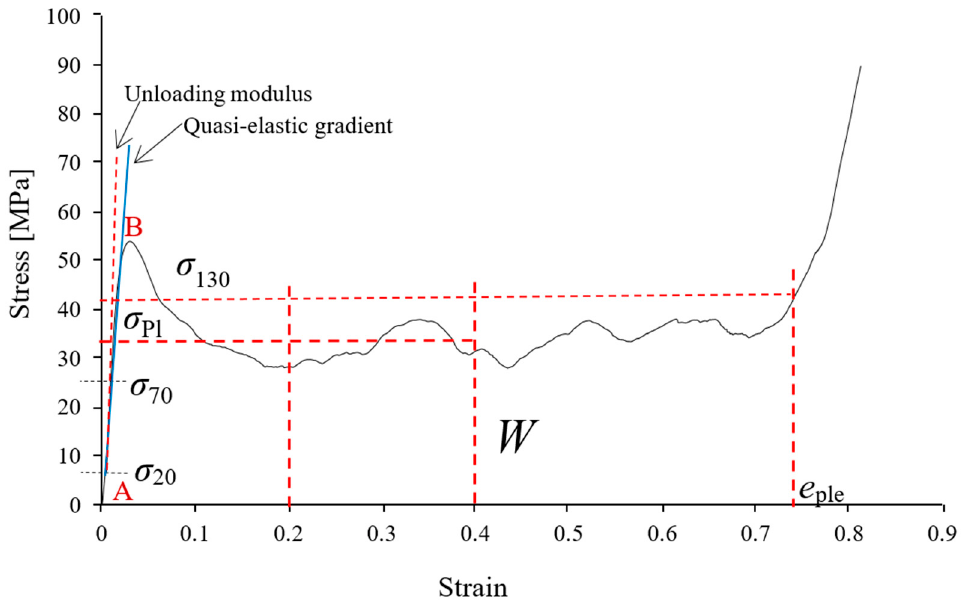
Figure 2. Engineering stress-strain curve of a metallic foam and related mechanical properties.